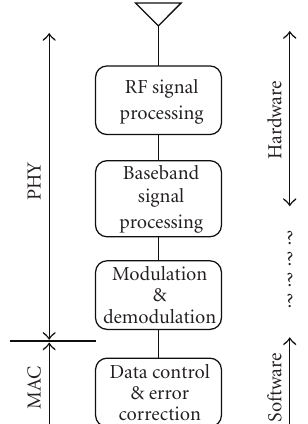
Figure 1: Partitioning between software and hardware in an SDR